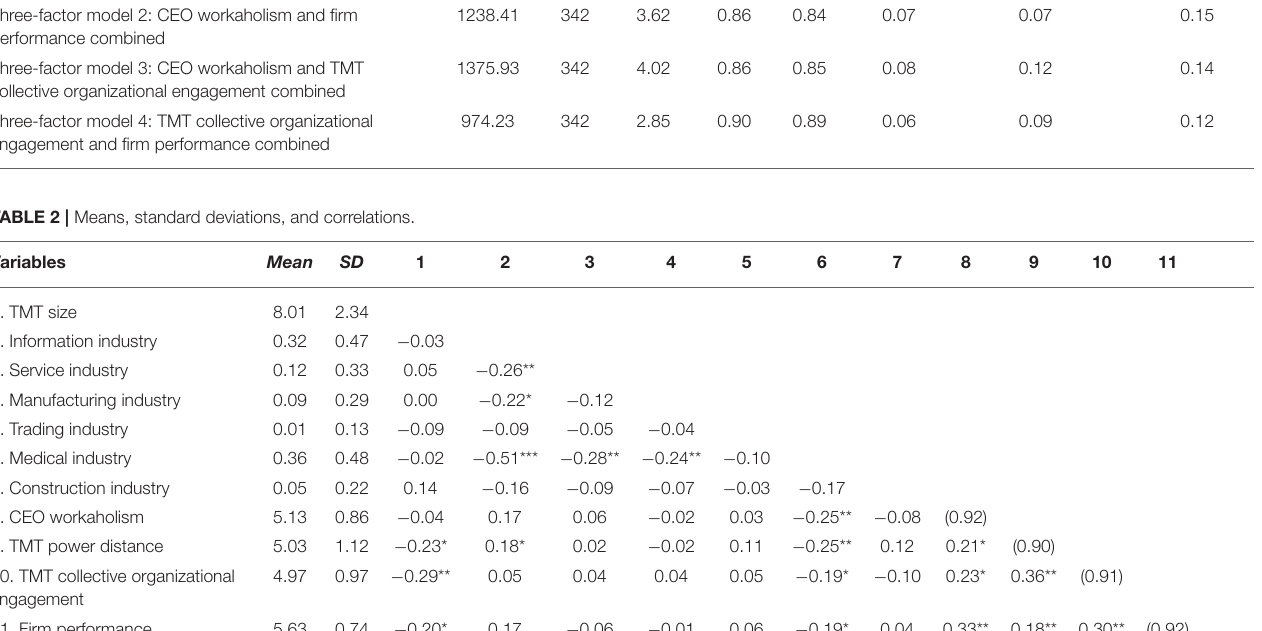
TABLE 1 | Multilevel confirmatory factor analysis results. Models χ 2 RMSEA SRMR for Four-factor model: Four factor separated